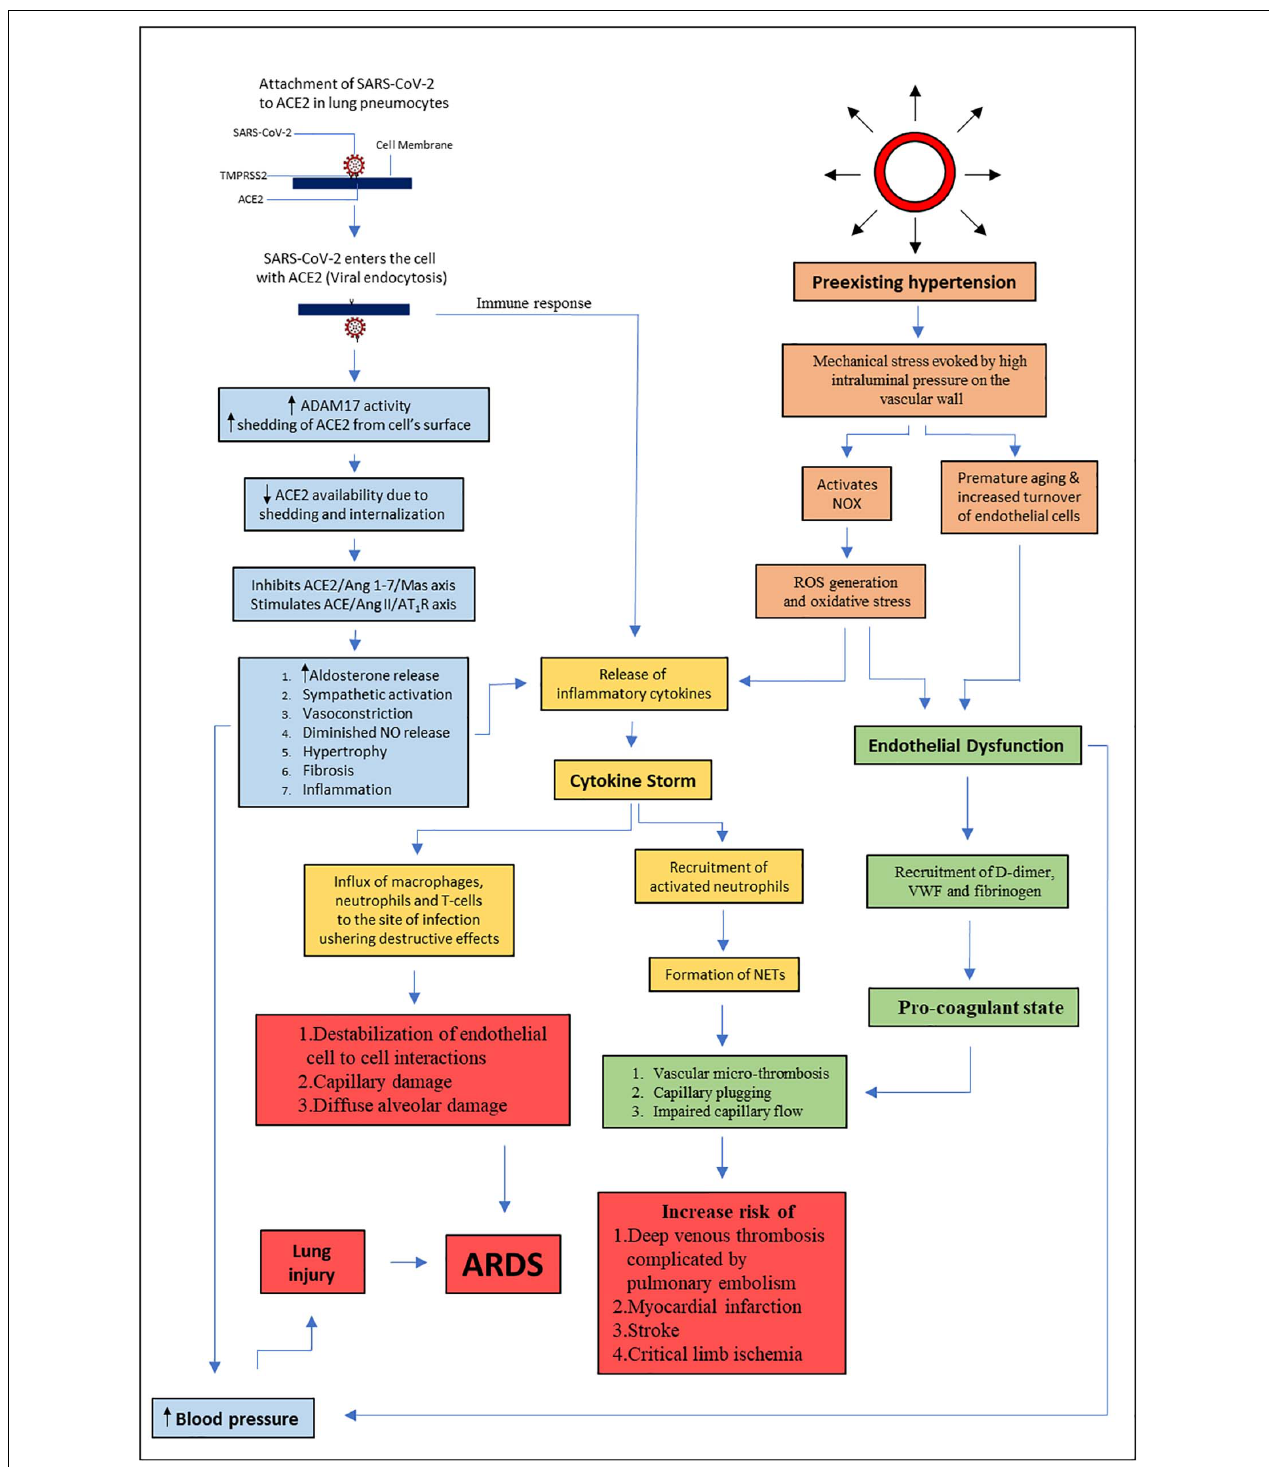
FIGURE 3 | Summary of the link between hypertension and COVID-19. This diagram visualizes the relationship between SARS-CoV-2 infection, RAS dysregulation, and endothelial dysfunction. ACE : angiotensin converting enzyme, ACE 2: angiotensin converting enzyme 2, Ang 1-7: angiotensin 1-7, Ang II: angiotensin 2, AT 1 R: angiotensin II type 1 receptor, NO: nitric oxide, ARDS: acute respiratory distress syndrome, SARS-CoV-2: severe acute respiratory distress coronavirus 2, TMPRSS2: transmembrane protease serine 2, ADAM17: ADAM metallopeptidase domain 17, NOX: nicotinamide adenine dinucleotide phosphate oxidase, ROS: reactive oxygen species, VWF: von Willebrand factor, NETs: neutrophil extracellular traps.